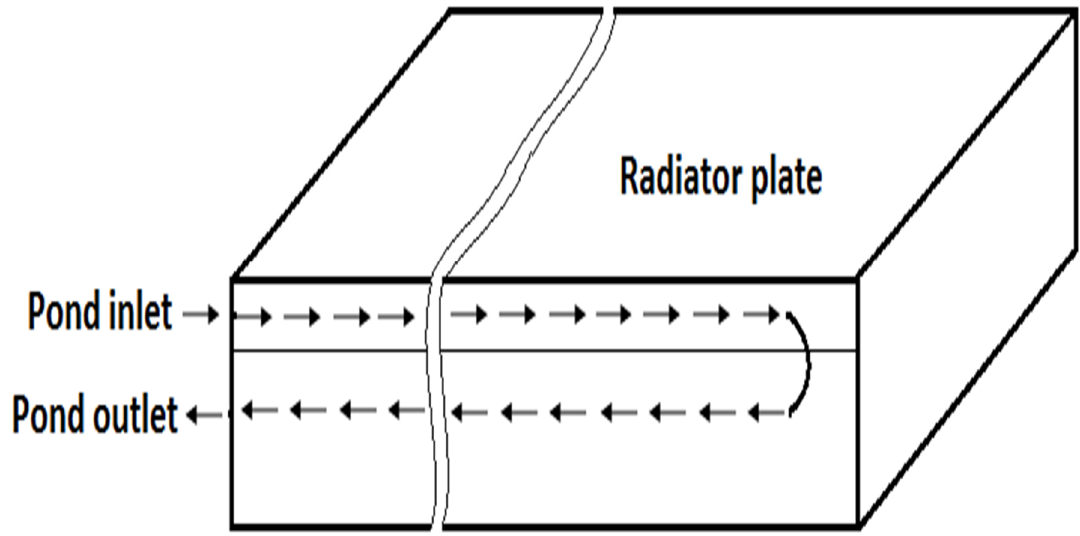
Figure 8. Night sky radiative cooling system used for cooling hot water from a power plant condenser (redrawn from [121]).